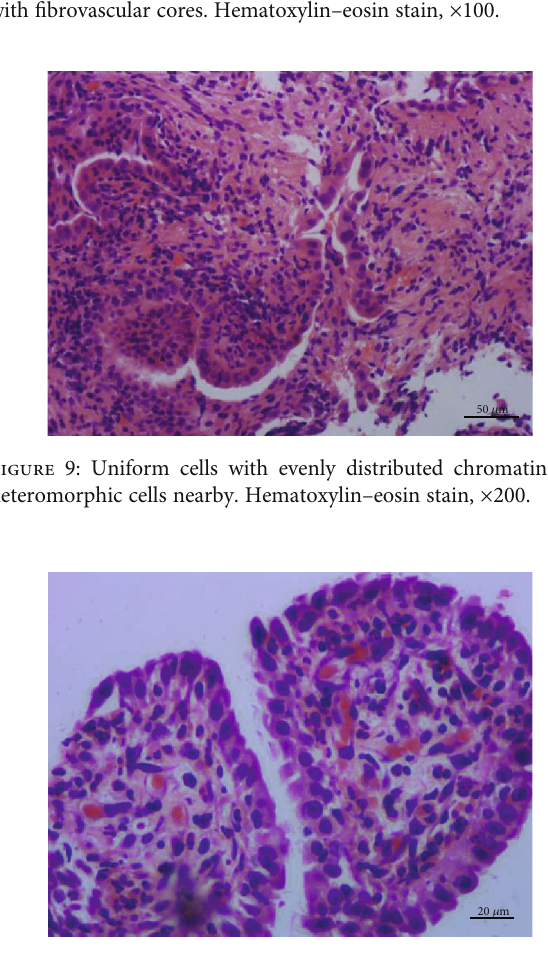
Figure 10: A large number of neutrophils, lymphocytes, and plasma cells in fi ltrated in the stroma of the fi brovascular cores. Hematoxylin – eosin stain, × 400.